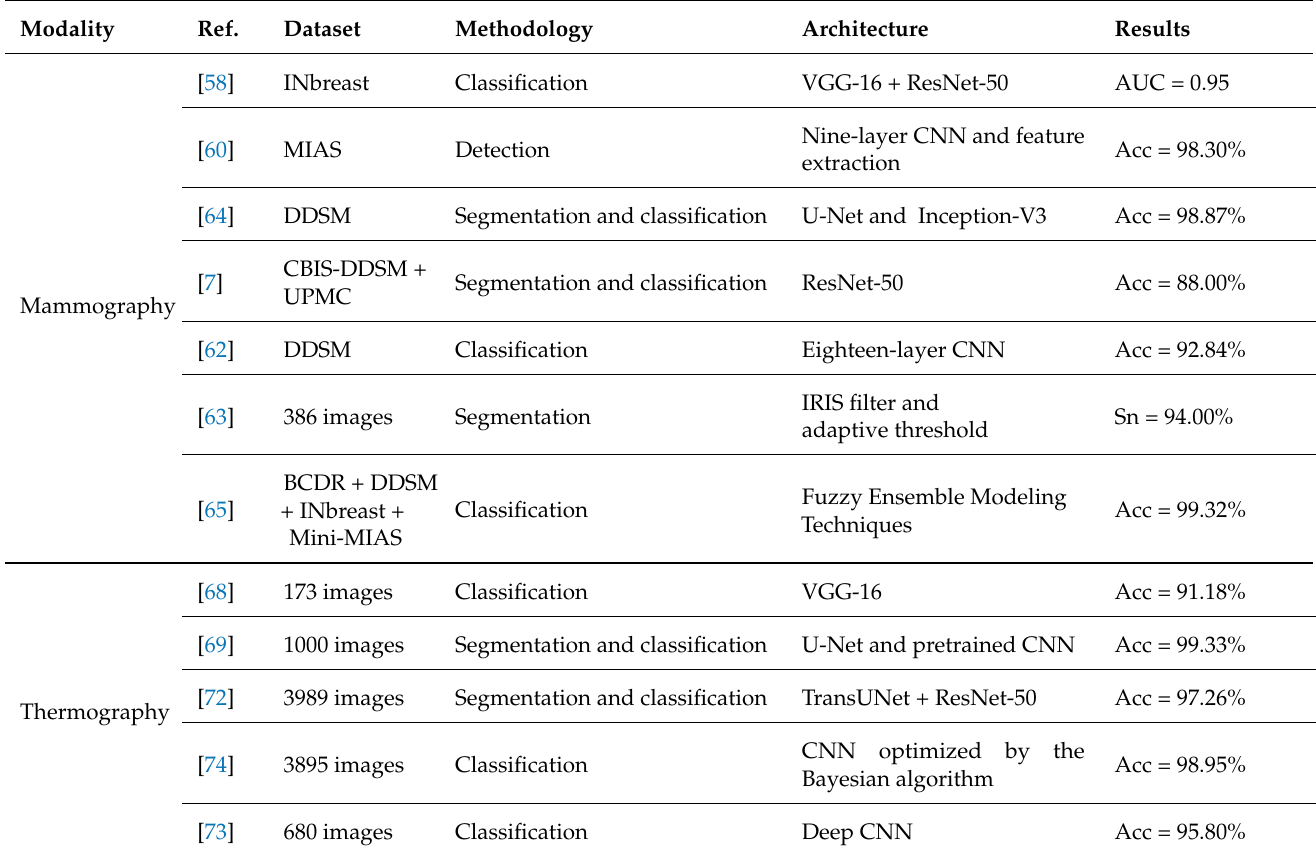
Table 3. Some of the state-of-the-art methods using breast cancer images. Acc: accuracy, Sn: sensitivity, AUC: area under the curve, Dc: Dice coefficient, IoU: intersection over union and AUC-ff: AUCs of the feature